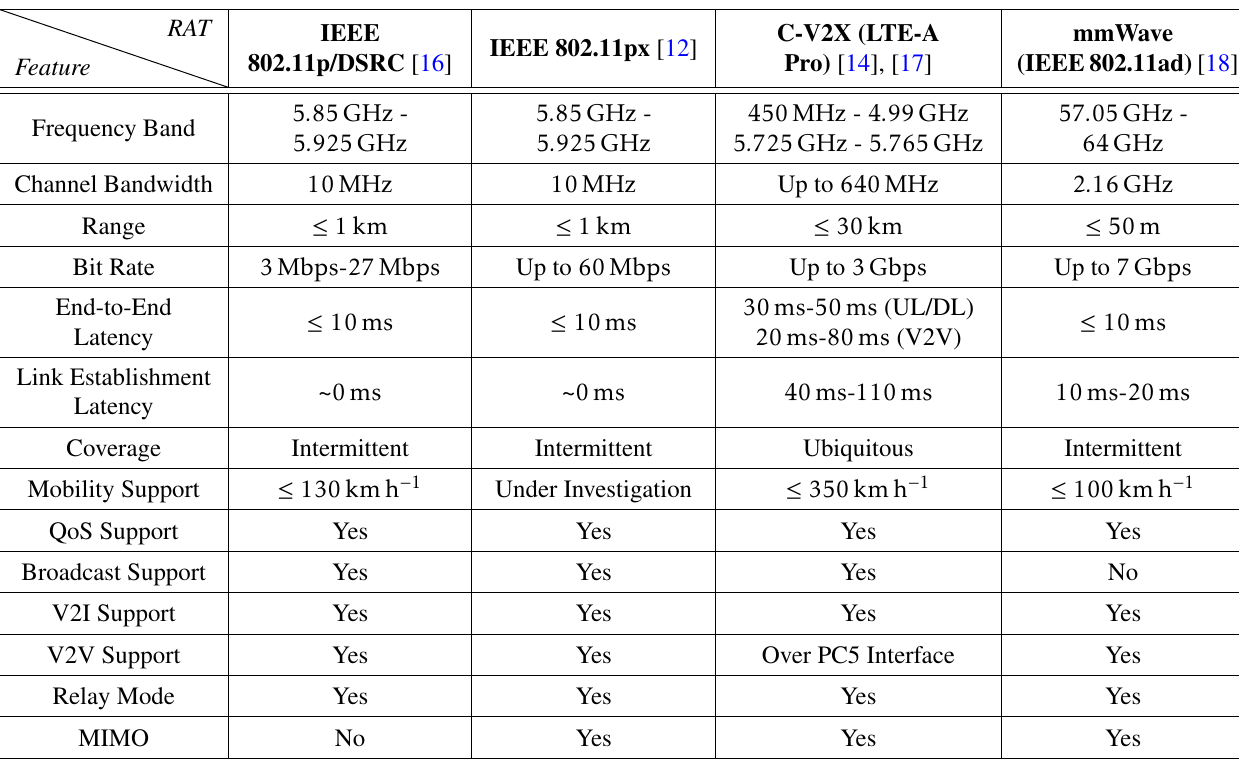
Table 1. Candidate RAT solutions for V2X